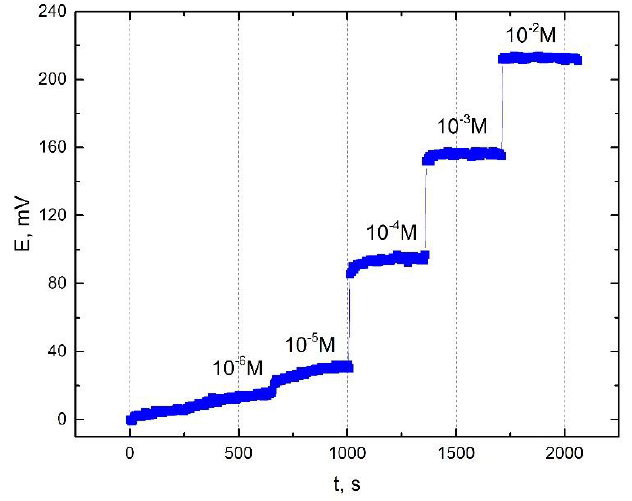
Figure 4. Typical response time curve for sensor L10 in Cs + solutions.